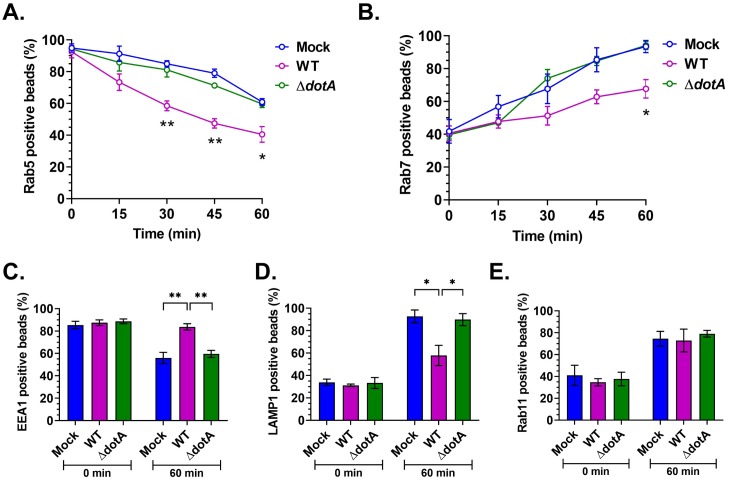
C. burnetii T4BSS alters latex bead phagosome maturation.Mock and C. burnetii-infected murine alveolar macrophages (2 dpi) were pulsed with 1 μm red fluorescent latex beads for 15 min, followed by fixation at 0 min post-pulse and every 15 min for 60 min. Cells were then immunostained for C. burnetii, plasma membrane, and Rab5 or Rab7 and internalized beads scored for co-localization with Rab5 or Rab7. The percent of Rab5 or Rab7 positive bead phagosomes over total number of internalized beads was plotted against time. In WT-infected cells, Rab5 was lost from bead phagosomes significantly faster than mock and ΔdotA-infected cells (A), whereas Rab7 localization to bead phagosomes was significantly slower in WT-infected cells (B). Further, bead phagosomes in mock, WT, and ΔdotA-infected cells were immunostained for EEA1, LAMP1, and Rab11 at 0 min and 60 min post-pulse. At 60 min post pulse, significantly more bead phagosomes retained EEA1, whereas WT-infected cells retained significantly more EEA1 compared to mock and ΔdotA (C), significantly fewer of those were positive for LAMP1 at 60 min post-pulse (D). There was no difference in Rab11 profile of bead phagosomes in between mock, WT, and ΔdotA-infected cells. Data shown as mean±SEM of at least 30 bead phagosomes per condition in each of three independent experiments as analyzed by multiple t-test (A, B) or one-way ANOVA (C-E); **, P<0.01; *, P < .05.